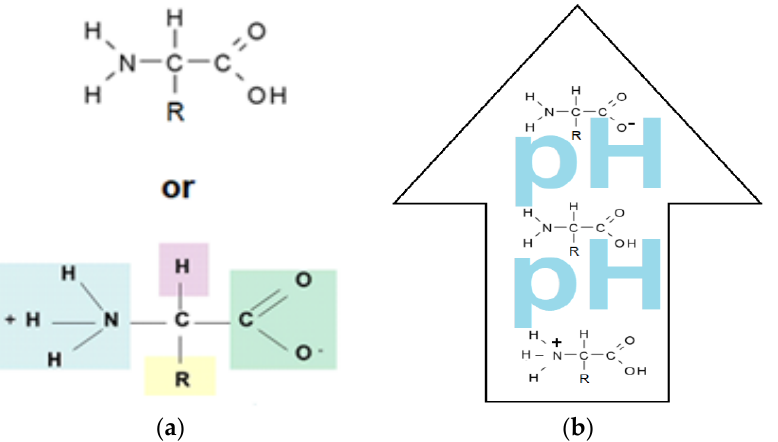
Figure 1. The chemical structure of amino acids ( a ) and the ionic forms depending on the pH of aqueous solution in which they are found ( b ).